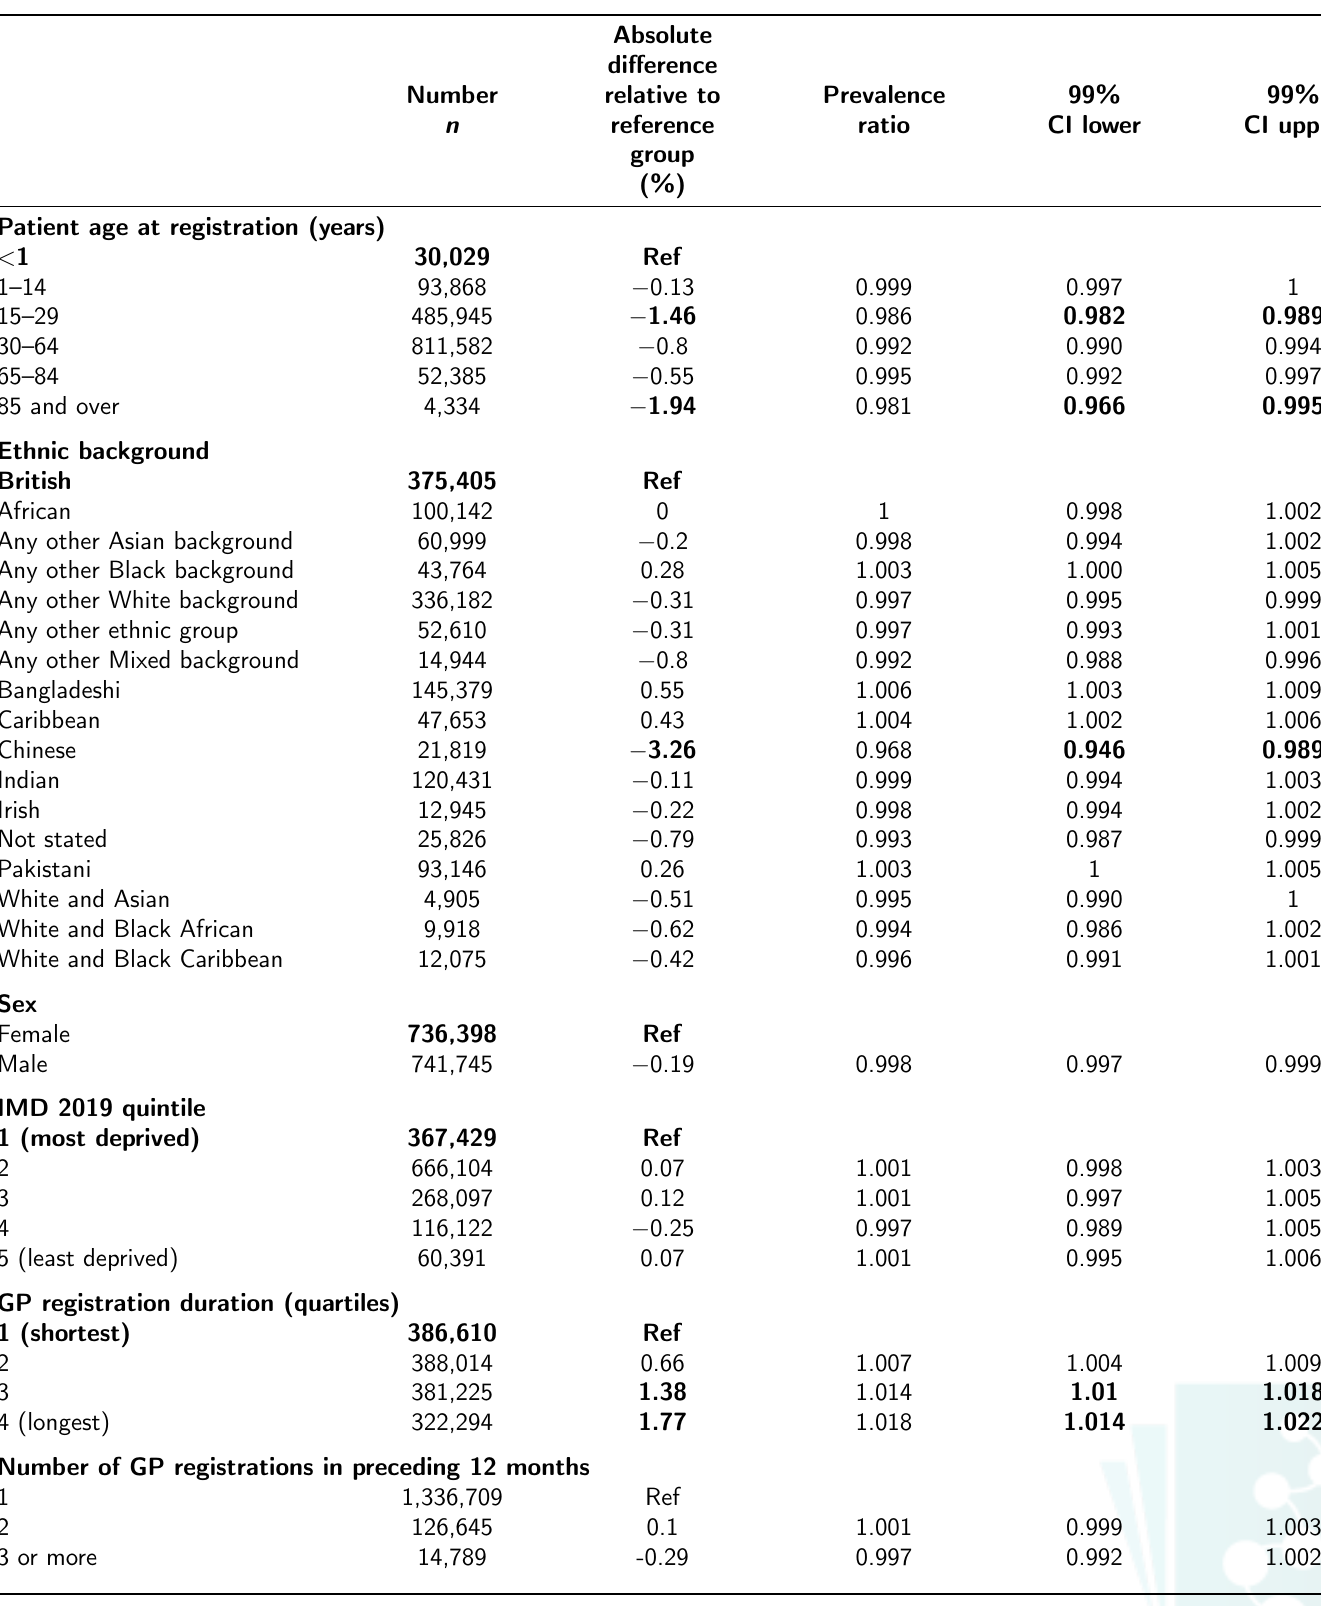
Table 5: Absolute differences in percentage of population matched to a UPRN, adjusted complete case analysis prevalence ratios and 99% CIs with respect to reference category by demographic, GP registration and organisational